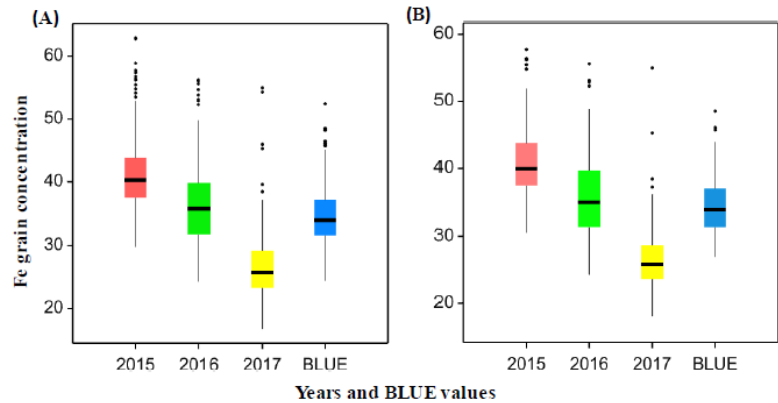
Figure 1. ( A ) Grain iron concentration ( µ g · g − 1 ) in all wheat genotypes of the whole panel for the years 2015, 2016 and 2017 and BLUE values. ( B ) Grain iron concentration ( µ g · g − 1 ) for wheat genotypes in